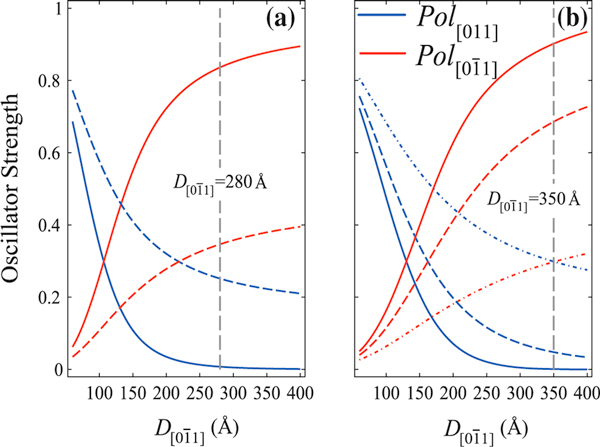
Calculated oscillator strengths for crossed linear optical polarizations along the directions [01¯1] (red line) and [011] (blue line) for two coupled QD's (Figure 1c) with semicylindrical shape and axis in the [01¯1] direction with (a) D[01¯1] = 280 Å, d = 160 Å upon strain order of ε|| = - 0.3% (solid line) and -0.9% (dashed line). (b) D[01¯1] = 350 Å, d = 330 Å and ε|| = - 0.1% (solid line), -0.2% (dashed line) and -0.3% (dashed-dotted line). The crossing point stands for isotropic optical emission.